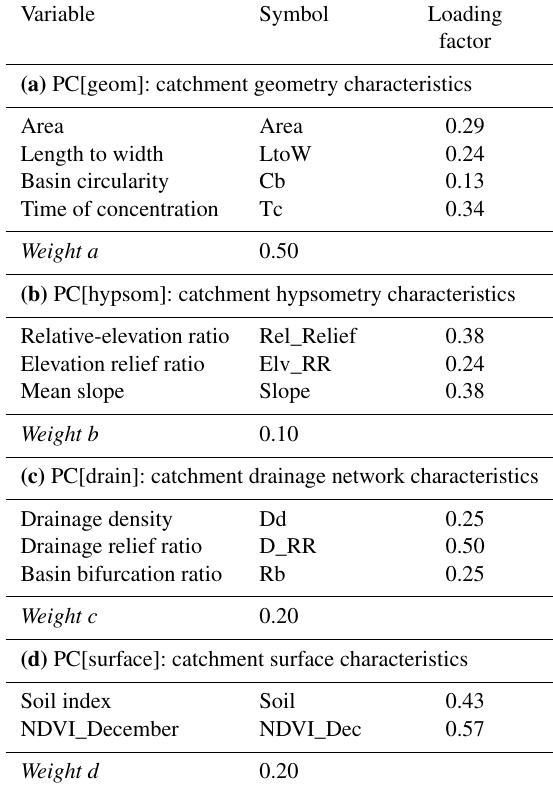
Table A1. List of indicators included in the principal component analysis per categories, resulted indicator loading factors, and cate- gory weights ( a , b , c , and d